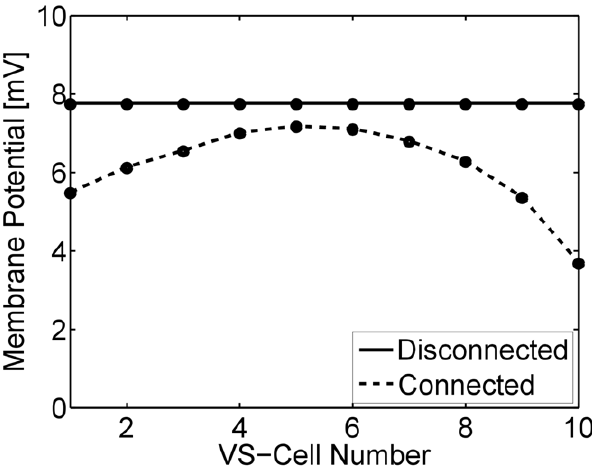
Figure 10. Responses of disconnected and connected VS cells to downward motion. We measured the response strength of all VS cells to a pattern moving homogeneously downward in all parts of the visual field. When disconnected (solid line), all VS cells respond identically. However, when fully connected (dashed line), the response to downward motion is suppressed. The effect is smallest for VS4-6 which are mainly only sensitive to downward motion. In contrast, VS1-2 and VS8-10 exhibit a more rotational receptive field structure and therefore respond weaker to downward motion.